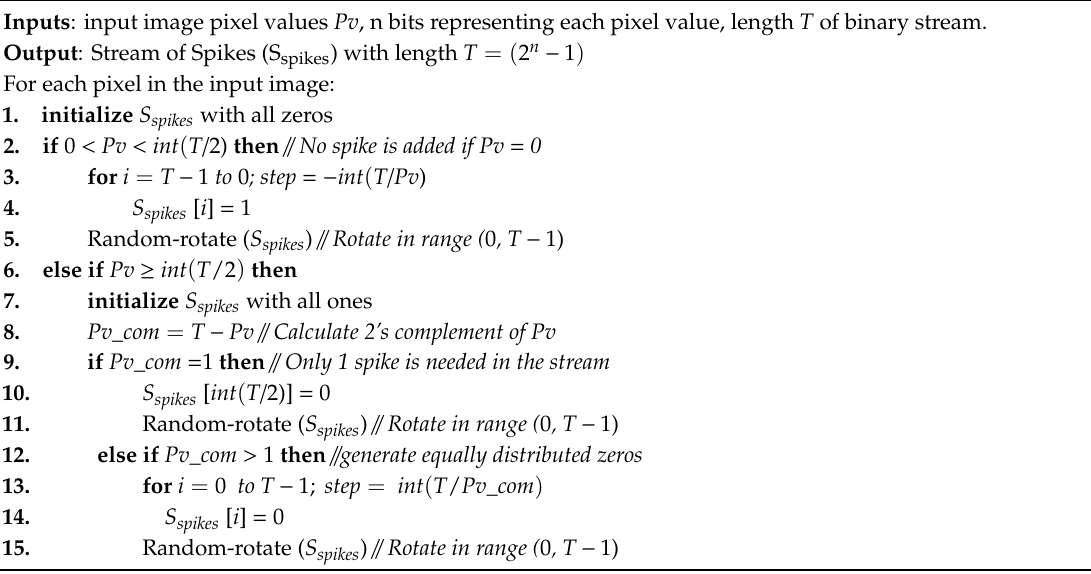
Algorithm 1 Generate Binary Stream of Spikes